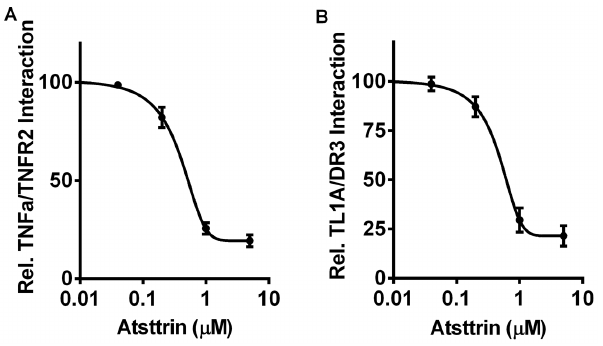
Figure 4. Atsttrin inhibits the binding of TL1A to DR3, similar to its inhibition of TNFa/ TNFR2 interaction. ELISA plate was coated with 100 ng of TNFa (A) or TL1A (B), and then 100 ng of TNFR2 or DR3 was added to each well respectively, in the presence of various Atsttrin, the bound TNFR2 or DR3 was detected by anti-TNFR2 or anti- DR3 antibody, followed by a secondary antibody conjugated with horseradish peroxidase.